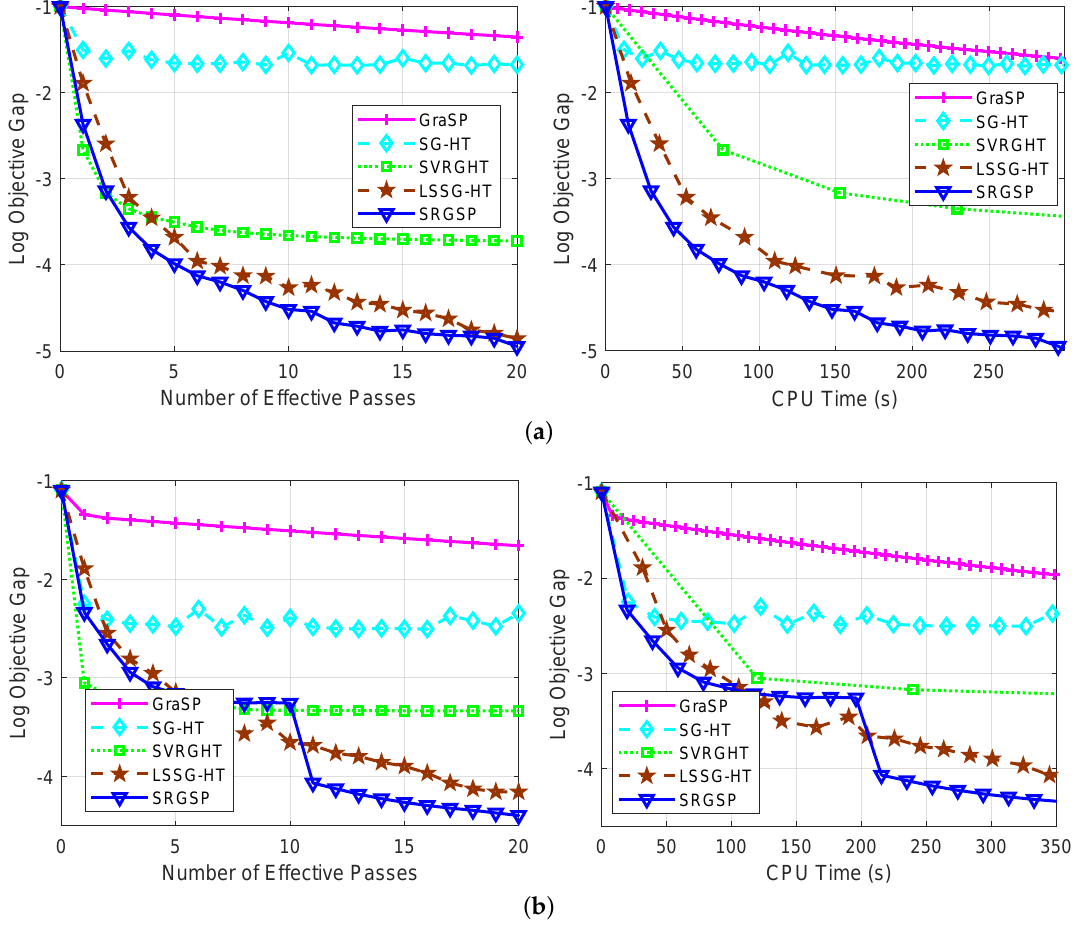
Figure 2. Comparison of GraSP [22], SG-HT [23], SVRGHT [24], LSSG-HT [34] and our SRGSP method for solving sparse linear regression problems. In each plot, the vertical axis shows the logarithm of the objective value minus the minimum, and the horizontal axis is the number of effective passes over data or running time (in seconds). ( a ) rcv1; ( b )